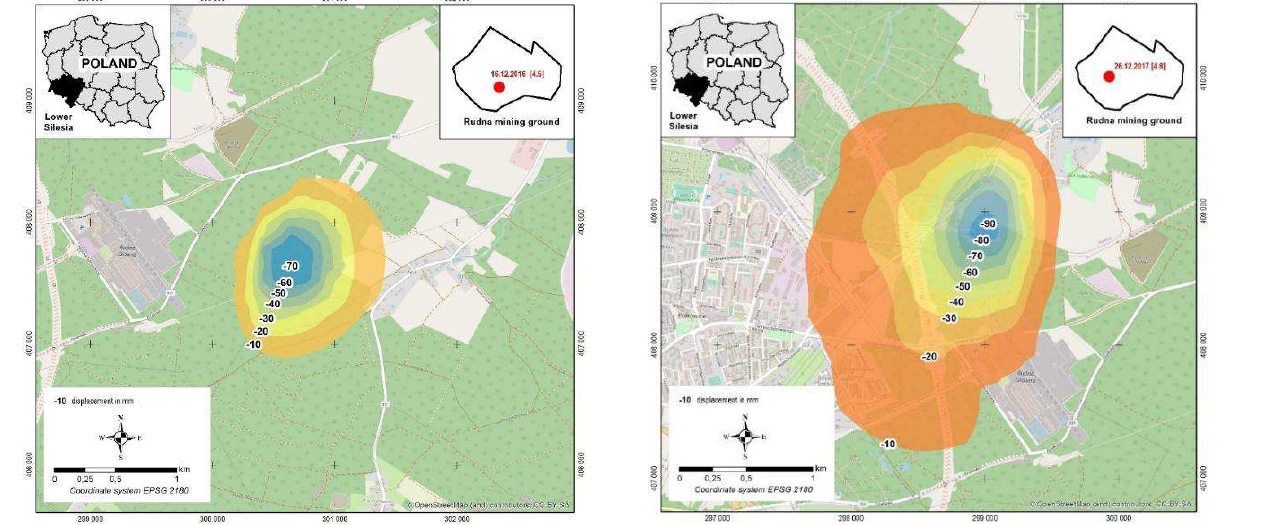
Figure 6. Map of the deformation resulting from the seismic event of 16 December 2016